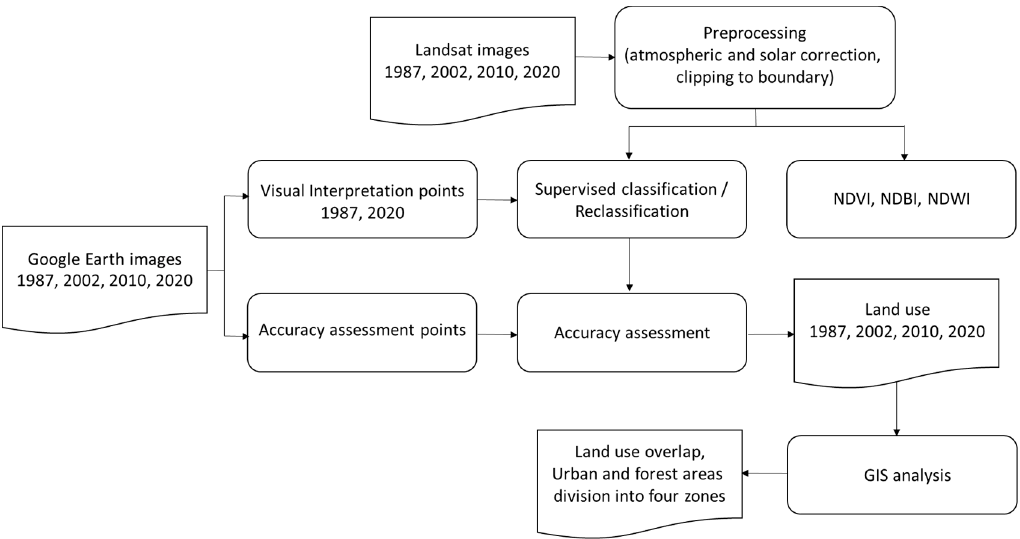
Figure 2. Workflow diagram; GIS: Geographic Information System; NDVI: Normalized Difference Vegetation Index; NDBI: Normal Difference Built-up Index; NDWI: Normal Difference Water Index